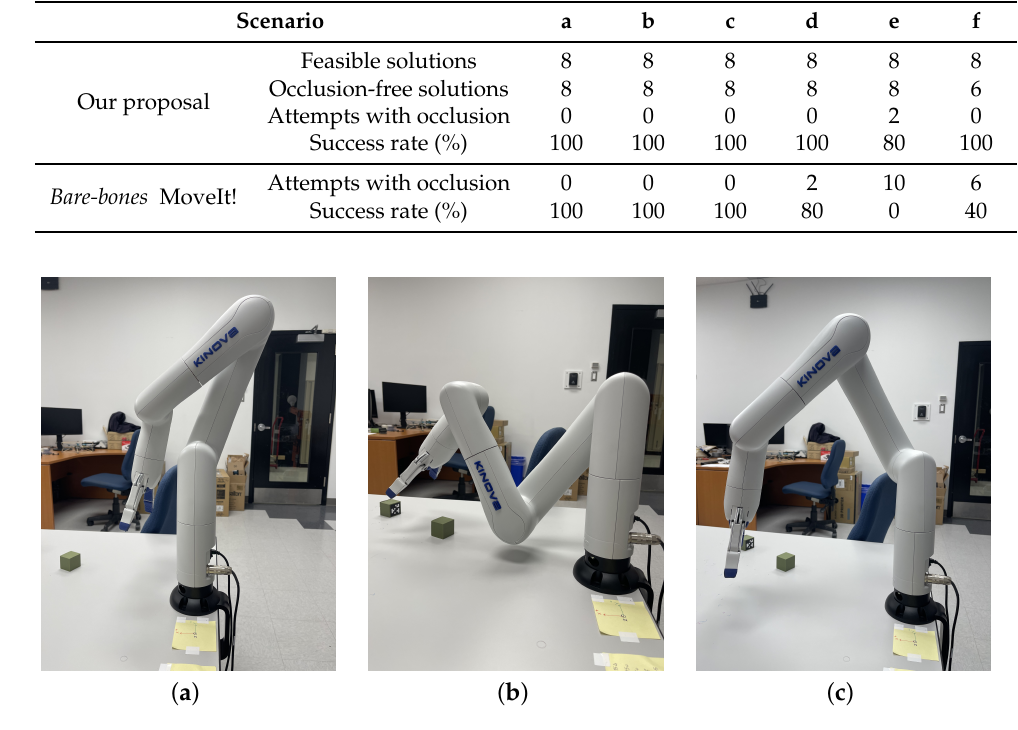
Figure 13. Initial positions of the grasping arm: ( a ) folded; ( b ) elbow-down; ( c ) elbow-up.